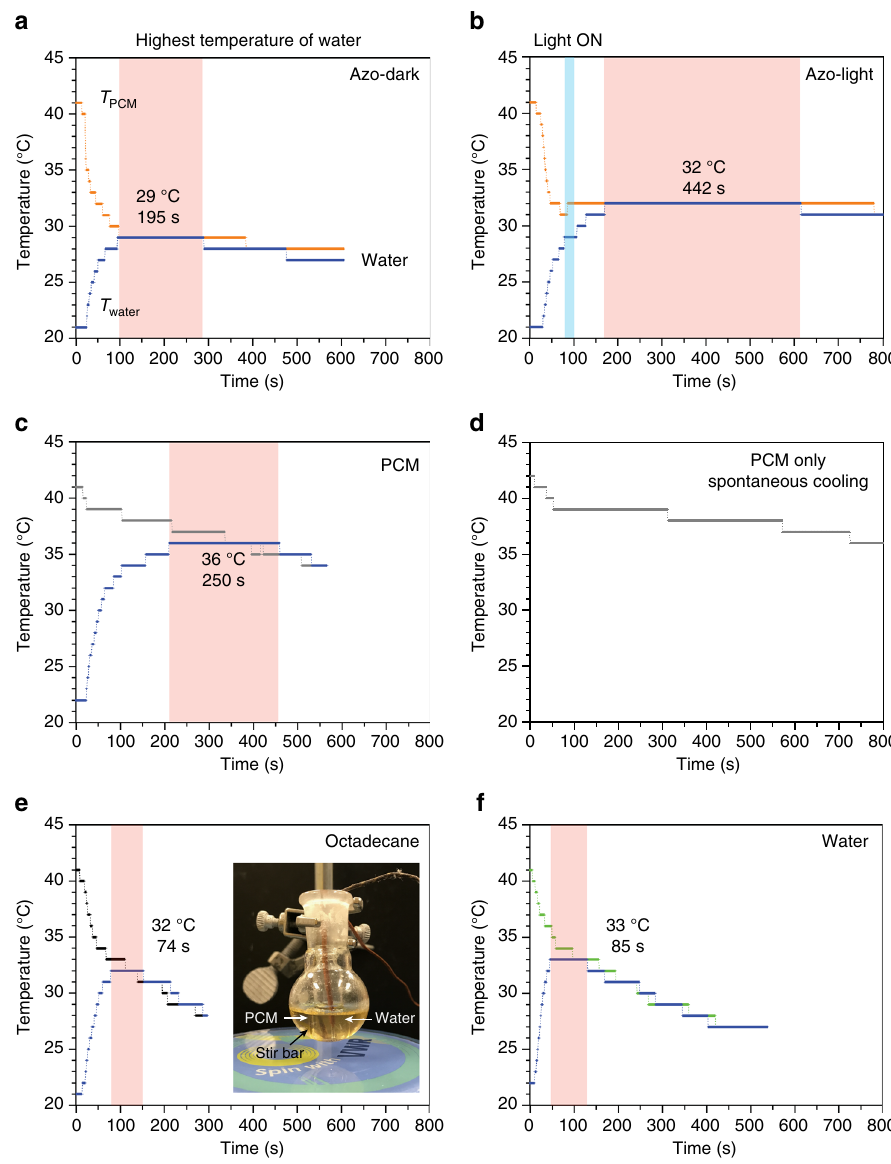
Fig. 5 Water-heating experiments. Showing the temperature changes of 1 g of water (blue curve) in contact with 3 g of a , ultraviolet-charged phase-change materials (PCM) composite (35 mol% of cis azobenzene dopant (compound 1 )) in the dark. b Optically triggered composite by the exposure to a blue light- emitting diode lamp at 31 °C for 500 s to maximize the discharging of cis azobenzene, ( c ) pristine PCM (i.e., tridecanoic acid), ( e ) octadecane, and ( f ) water bath. The inset of ( e ) shows the setup where each thermocouple is submerged in a heating medium and in a vial containing water. The temperature of water in the vial is at 21 – 22 °C under ambient condition and quickly increases as the vial is immersed in the heating medium at 40 °C. The temperatures of the heating medium ( T PCM ) and water ( T water ) are recorded simultaneously after T PCM reaches 41 – 42 °C while the heating fl uid is stirred. d Temperature change of pristine PCM under ambient condition without the process of dipping a water container into the PCM heating